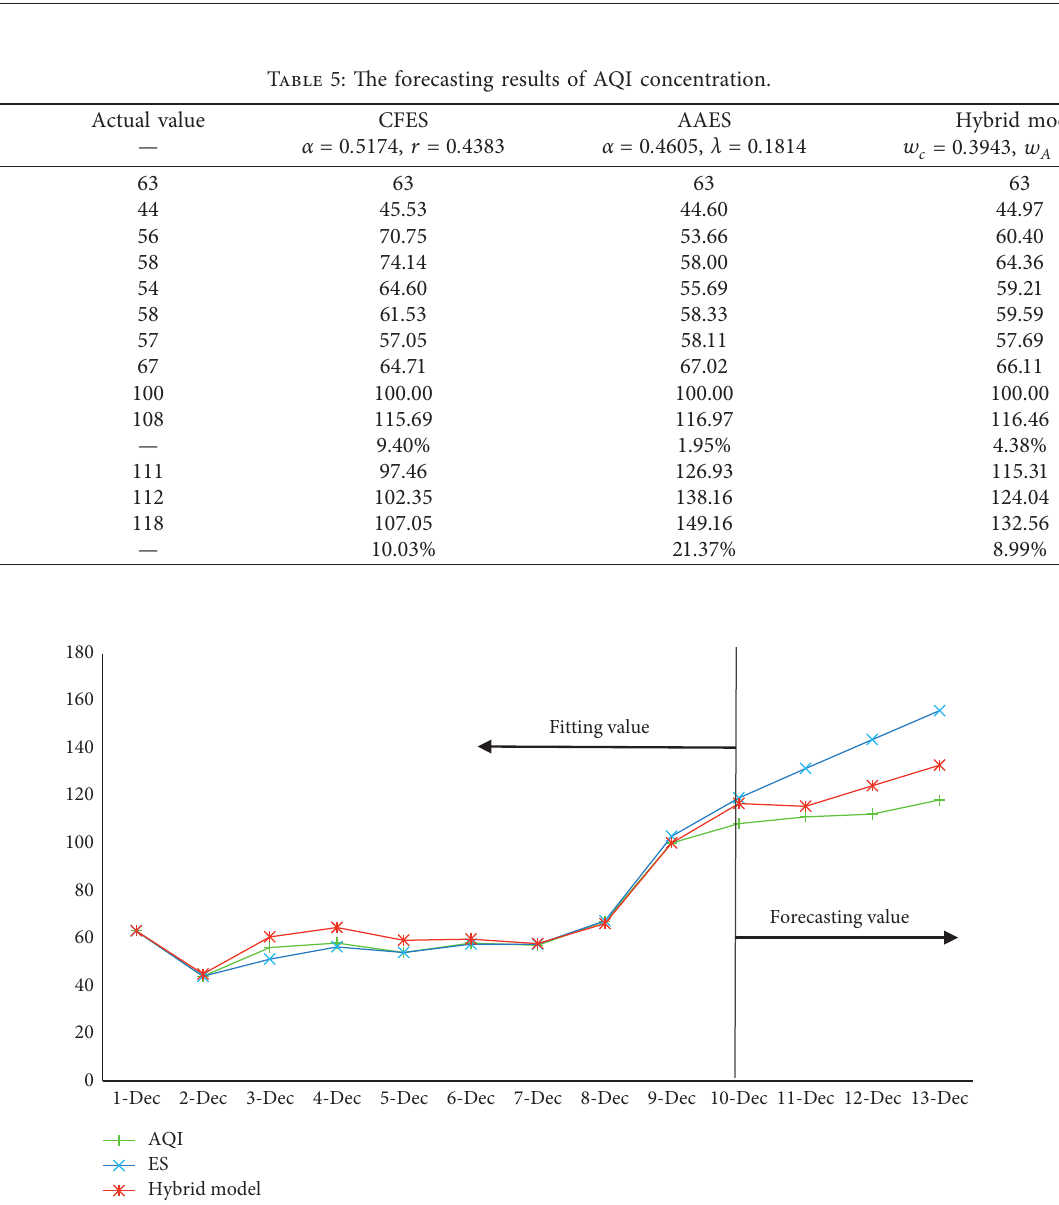
10 concentration.